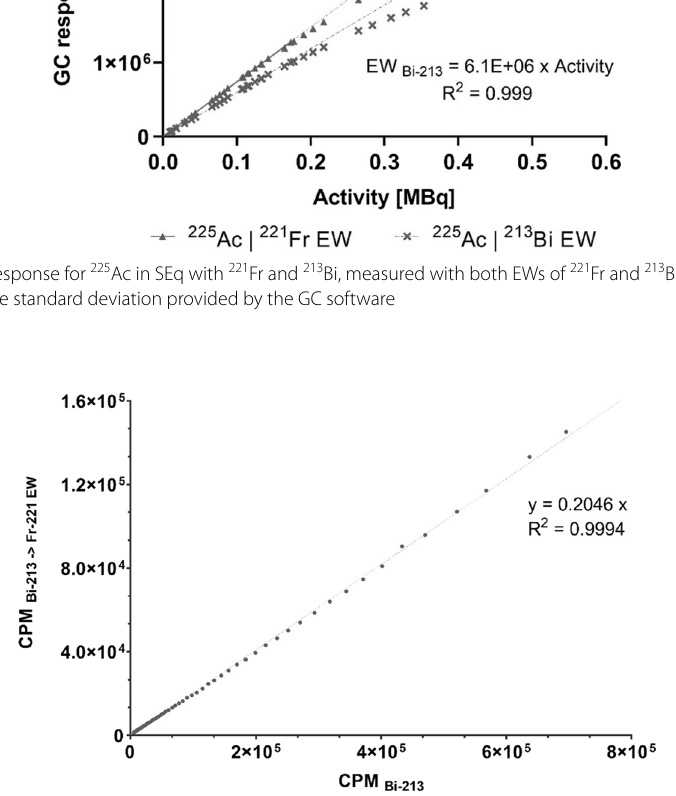
( CPM 213 ) for Fr Bi → EW 221Fr ( CPM 213 Bi Bi